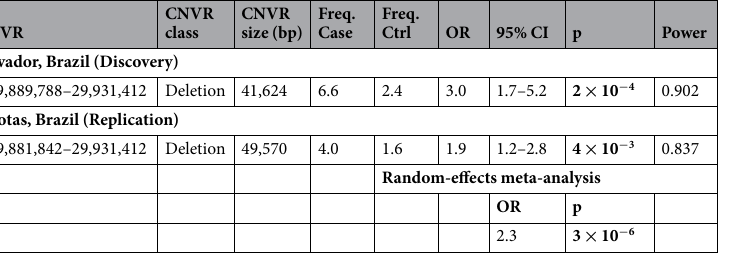
Table 3. A deletion region located in the locus 6p22.1 is associated with asthma in two independent Brazilian populations. CNVR: Copy number variation region, chromosome:start-end; bp: base pair; Frequency of CNVR (%); Case: asthmatic; Ctrl: non-asthmatic; OR, odds ratio; SE, SE of odds ratio (OR); 95% CI, 95% confidence interval; p, p value (additive model). The significance threshold established for the discovery phase was p ≤ 3.4 × 10 − 4 ; The significance level applied in the replication study was p = 0.05; Power: A posteriori statistical power. Covariates in multivariate analysis: sex, age, Log 2 of R ratio standard deviation (LRRSD) and principal components (PC1, PC2 and PC3). Human genome assembly: